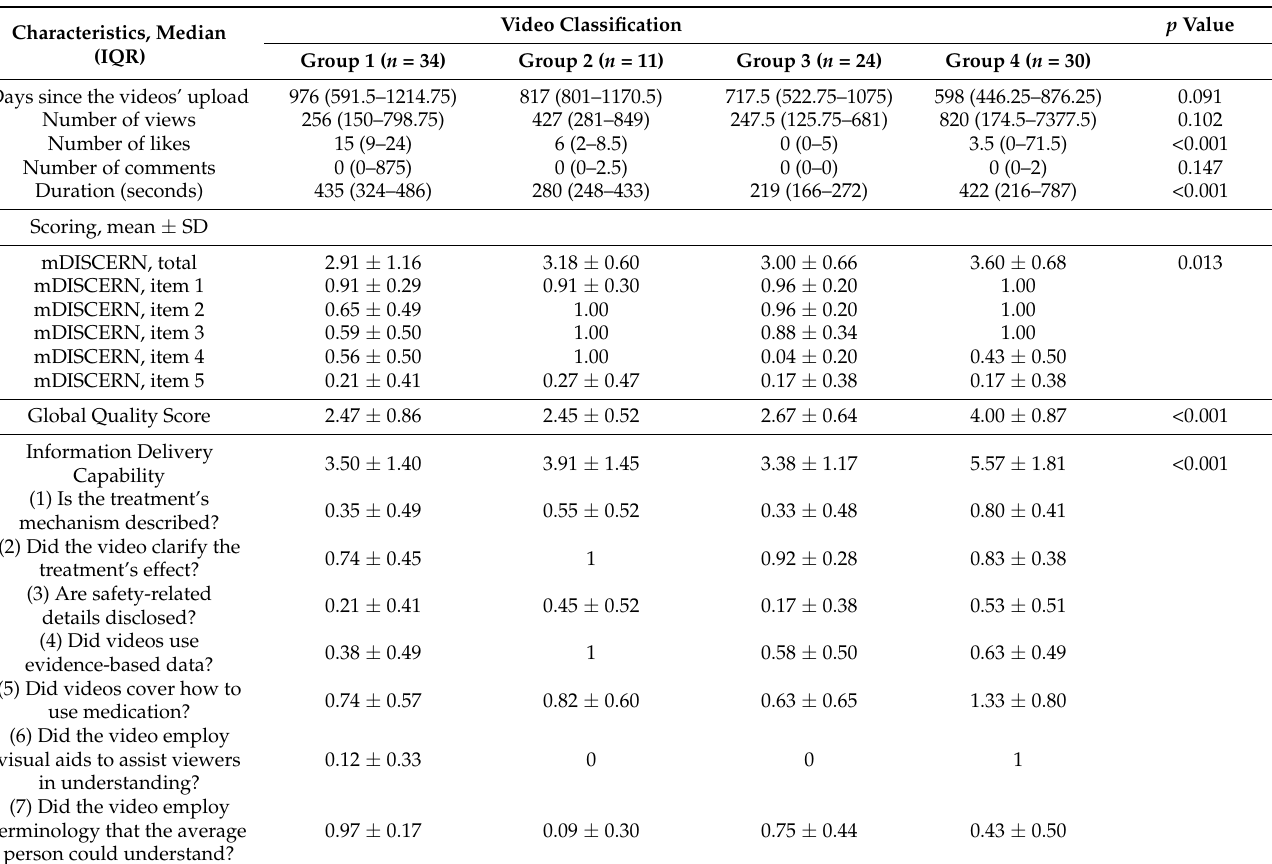
Table 3. Characteristics of the videos according to a subgroup (expertise of lecturer and educational